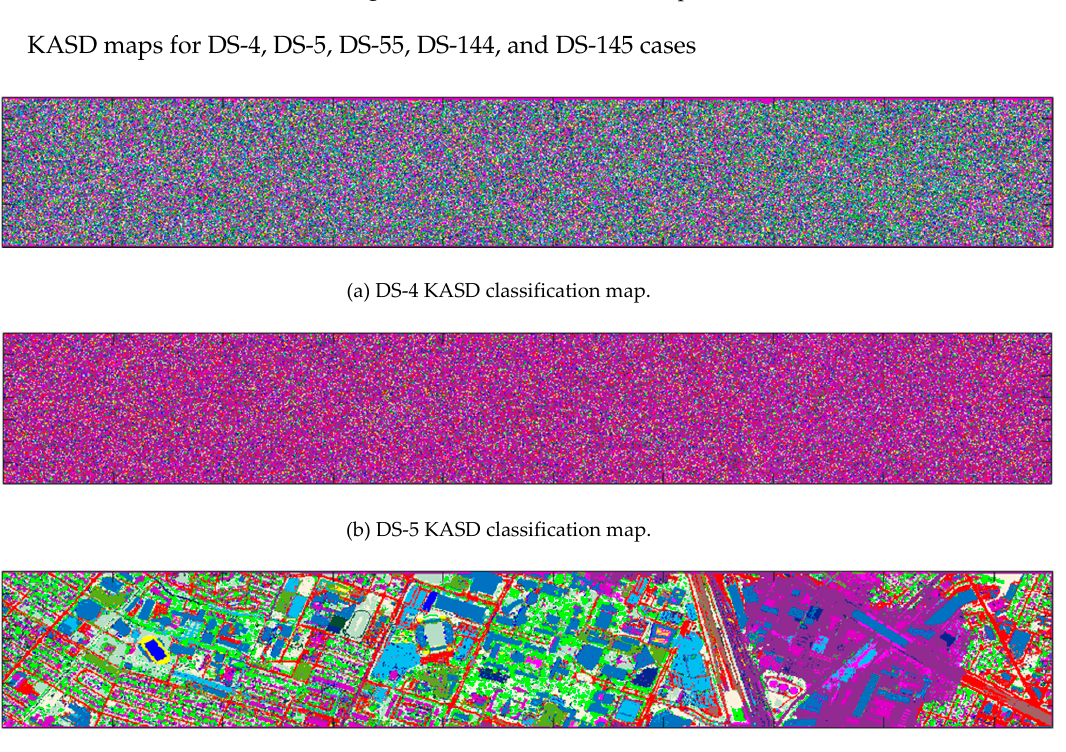
Figure A3. RXD classification maps.